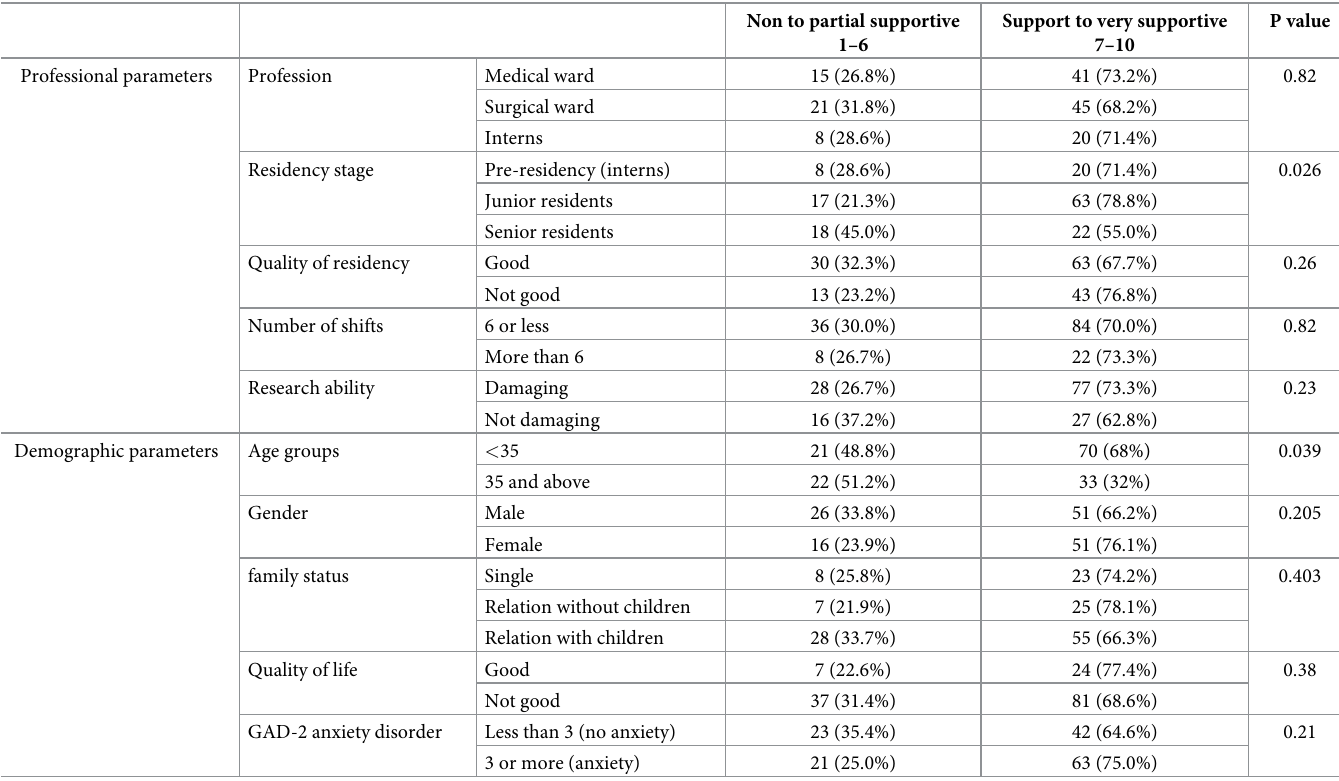
Table 1. Compression of professional and demographic characteristics between supporters and non-supporters of the new shift